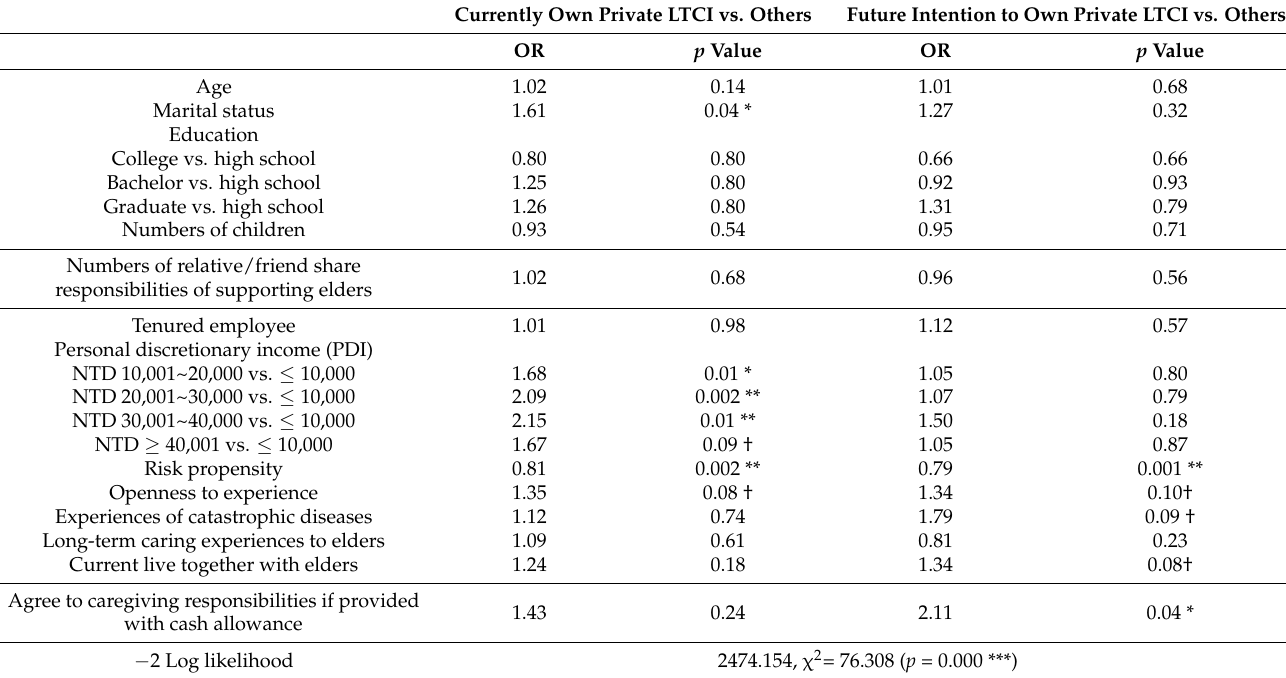
Table 3. Multinomial logistic regression result of the effects of indicators on LTCI ownership. Currently Own Private LTCI vs. Others Future Intention to Own Private LTCI vs. Others OR p Value OR p